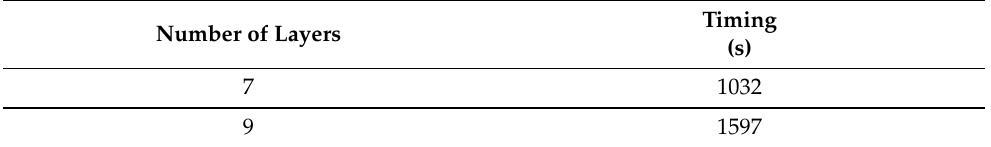
Table 1. Timing comparison between the implementation of our proposed algorithm using 7 and 9 layers, respectively.